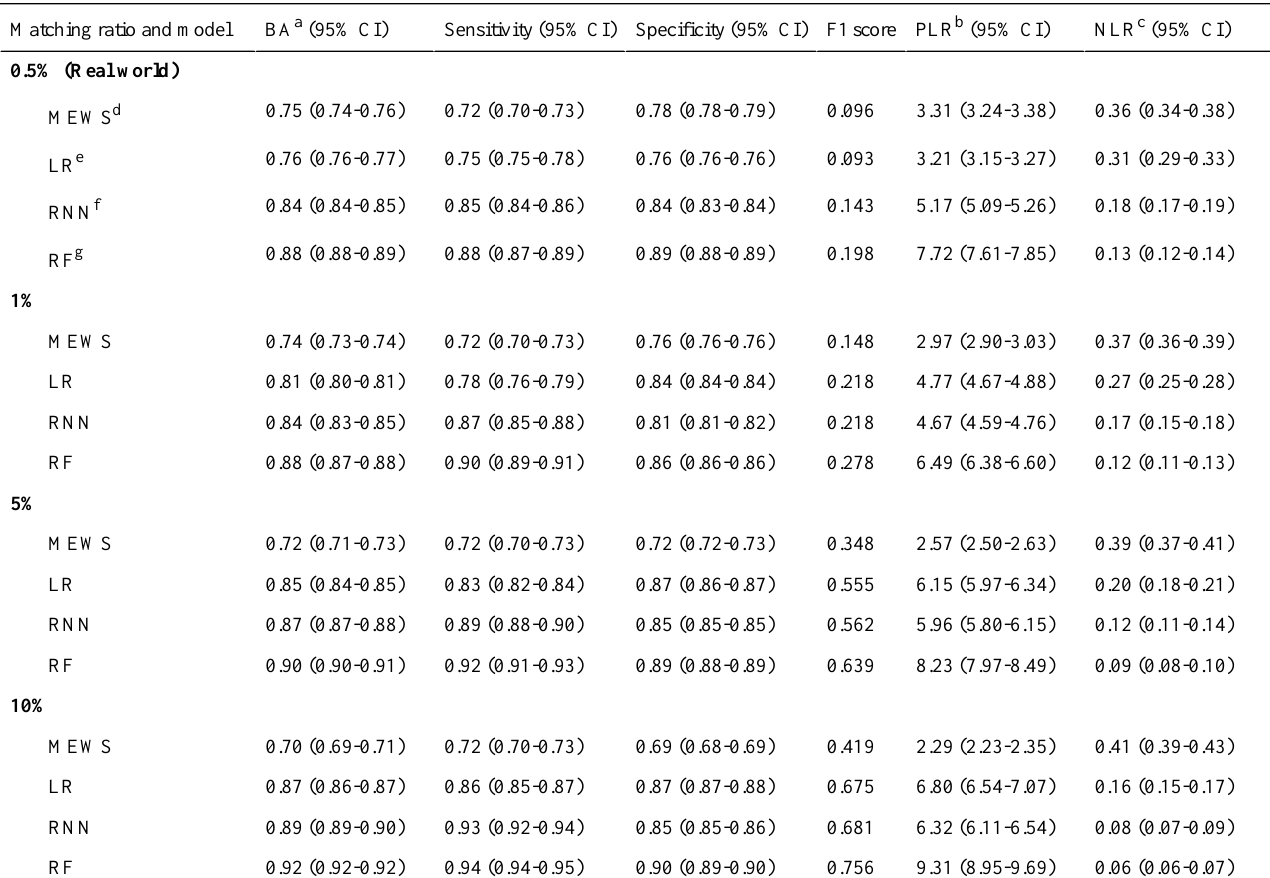
Table 4. Class prediction performance of each machine learning algorithm with imbalance adjustment in the validation